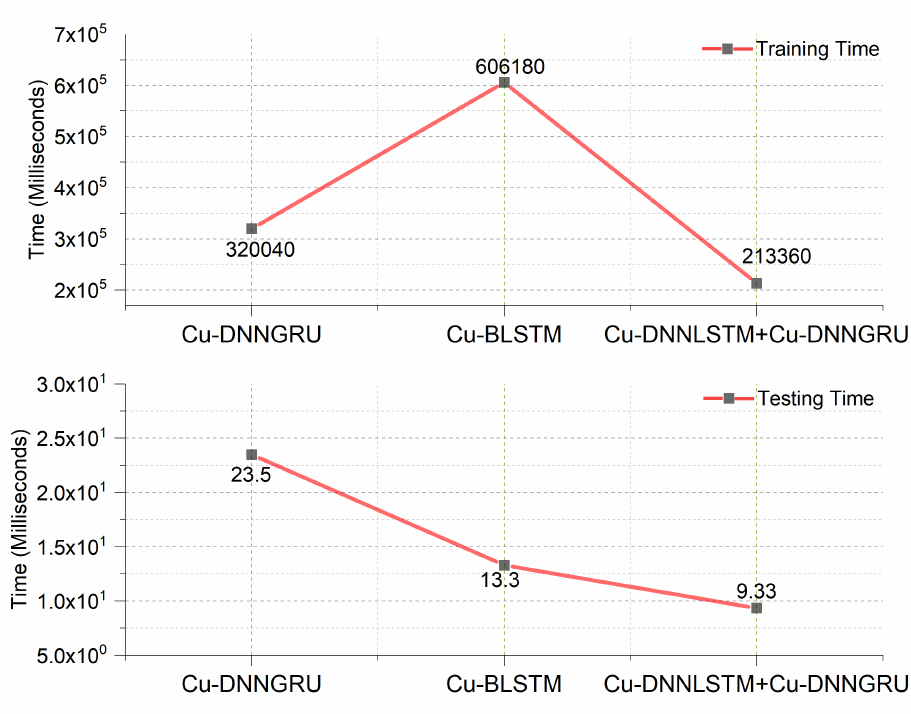
Figure 8. Training and testing